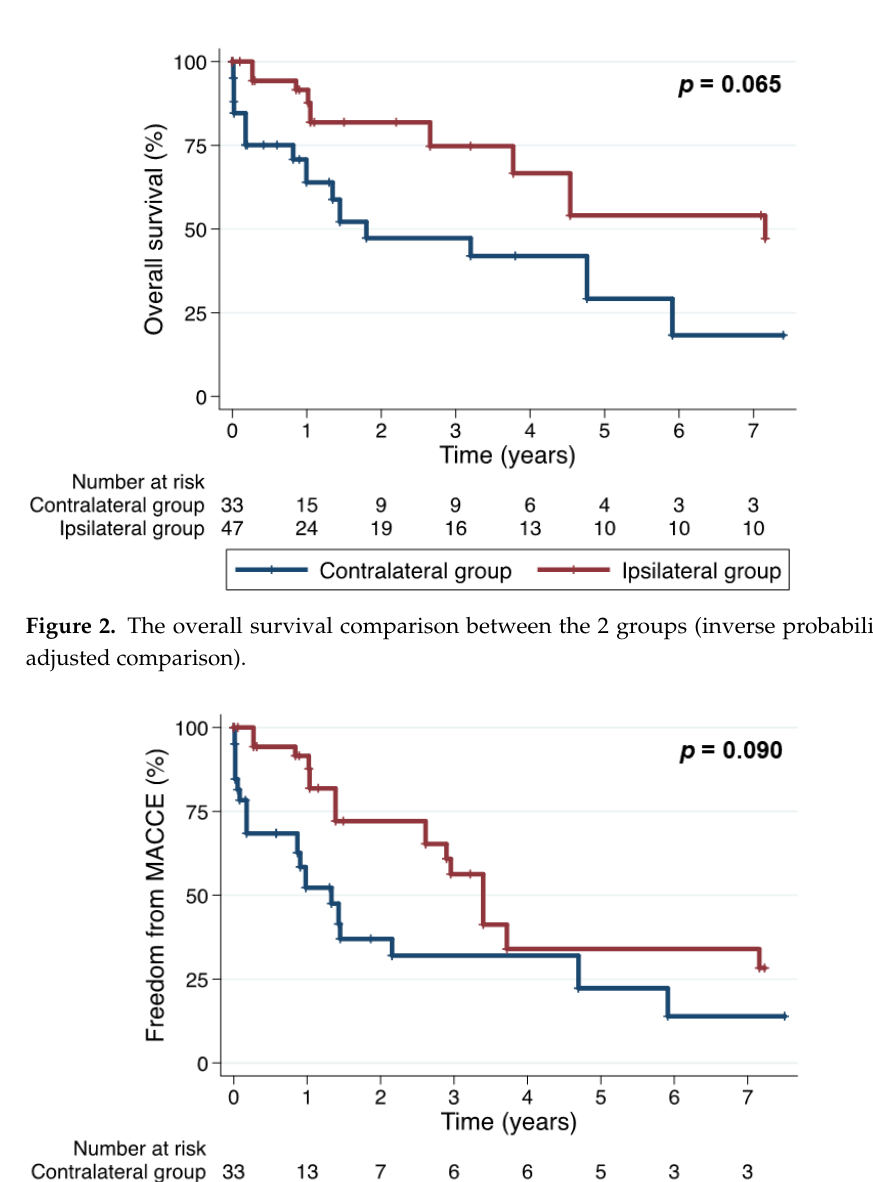
Figure 4. Freedom from the composite outcome of recurrent angina and coronary re-intervention (inverse probability weighting-adjusted comparison). 3.6. Risk Factor Analysis for Late Cardiac Events 3.6.1. Before IPW-Adjustment The multivariable Cox regression model revealed that using the in situ ITA on the ipsilateral side of the AVF was not a significant predictor of both MACCE (hazard ratio (HR), 0.495; 95% confidence interval (CI), 0.168–1.461; p = 0.203) and the composite out- come of recurrent angina and coronary re-intervention (HR, 0.635; 95% CI, 0.153–2.641; p = 0.533). Among the baseline characteristics, left ventricular dysfunction (HR, 5.180; 95% CI, 1.864–14.394; p = 0.002) and PAOD (HR 4.185, 95% CI 1.349–12.979, p = 0.013) were independent risk factors for MACCE. Acute myocardial infarction and previous history of myocardial infarction were the independent risk factors of the composite outcome of recurrent angina and coronary re-intervention (HR, 3.705; p = 0.022 and HR, 3.617; p =